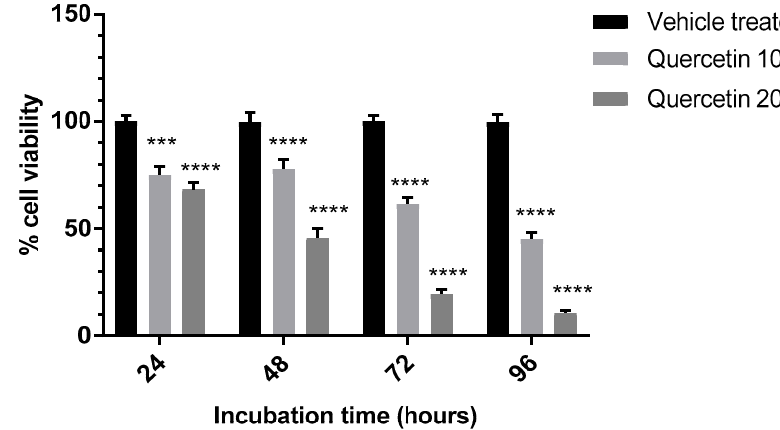
Figure 2. The anti-proliferative effect of QE treated 1321N1 cells. Cells at the density of 2 × 10 4 cell/well were incubated with 100 and 200 µM for up to 96 h. Cells were then subjected to MTT assay and the resulting absorbance values are expressed as percentages with respect to vehicle-treated cells. The bars represent mean ± SEM ( n = 8 for 24 h, 16 for 48 h, 24 for 72 h and 16 for 96 h). *** p = 0.0007 and **** p < 0.0001.